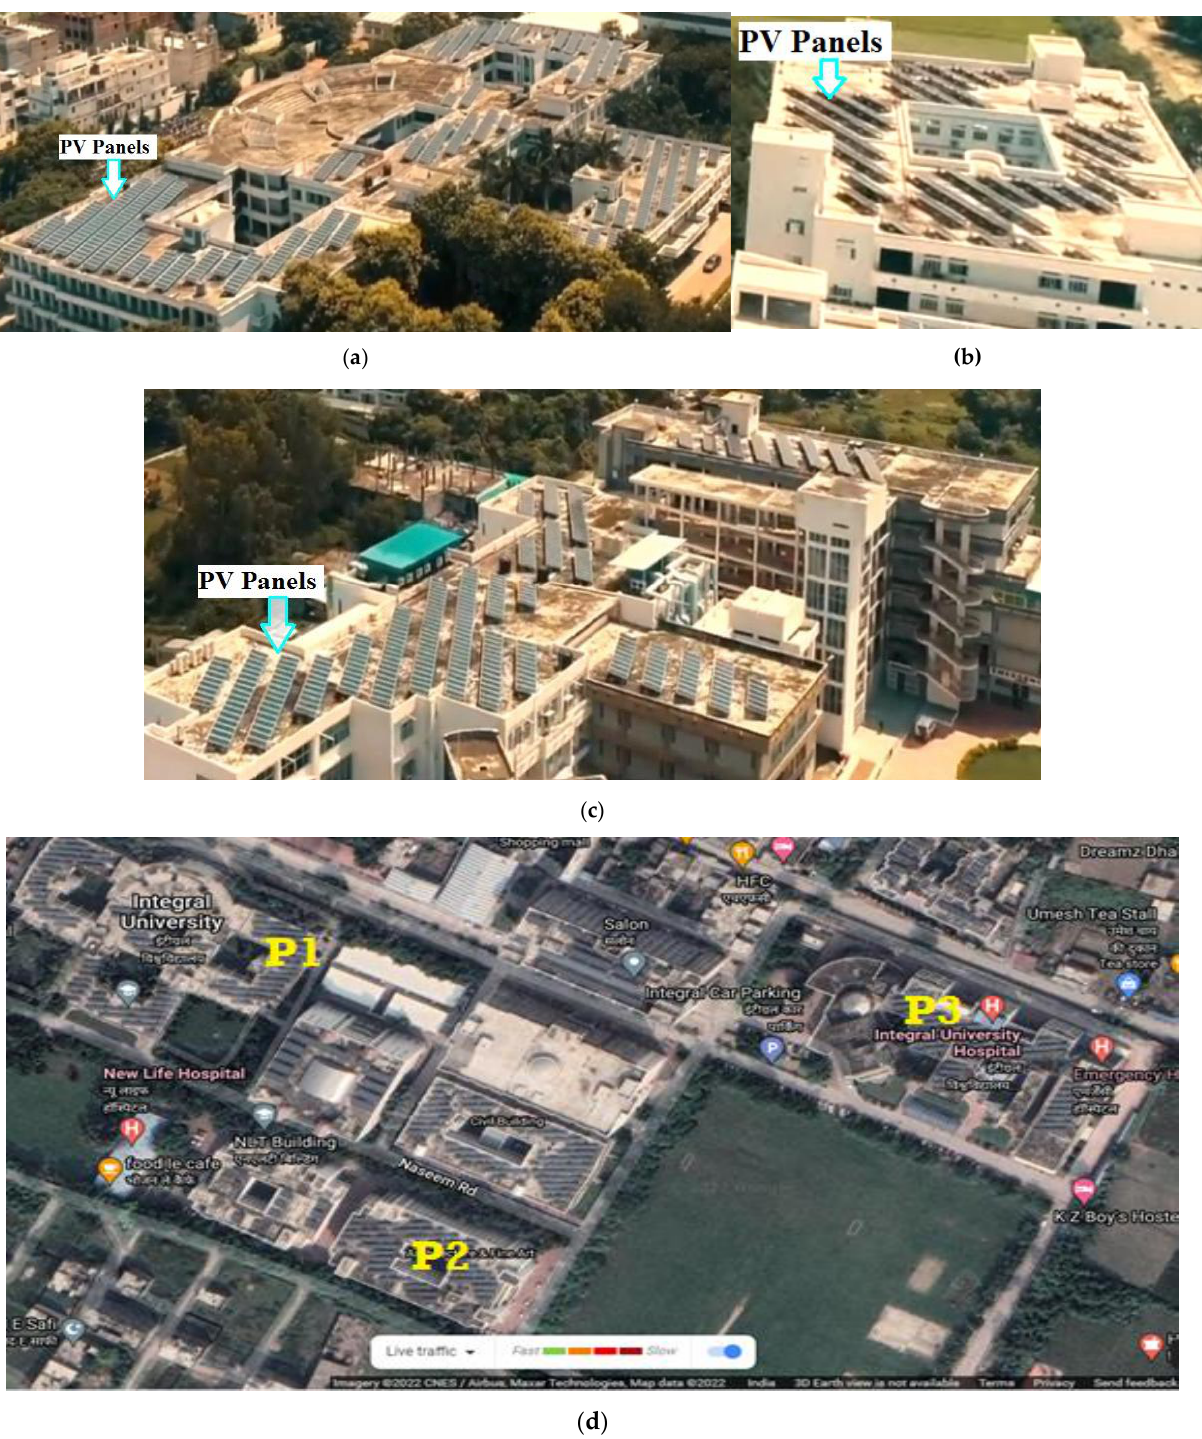
Figure 3. ( a ) 230.4 kWp Rooftop Solar PV System (P 1 ); ( b ) 108.8 kWp Rooftop Solar PV System (P 2 ); ( c ) 128 kWp Rooftop Solar PV System (P 3) . ( d ) Aerial view of the considered (P 1 , P 2, and P 3 ) SPV Plant